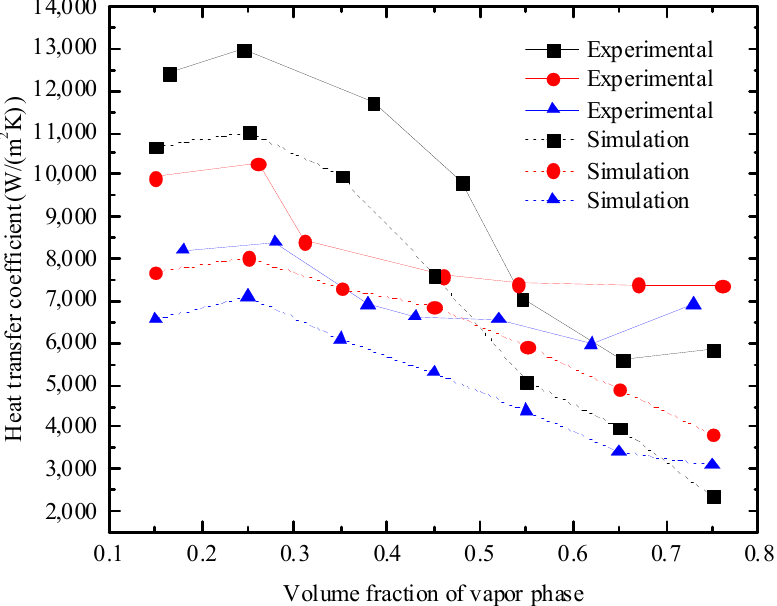
Figure 3. Change in heat transfer coefficient with dryness (the experimental conditions include D = 6 mm, G = 240 kg/m 2 · s, T sat = 283 K, and q = 10–20 kW/m 2 [7]).